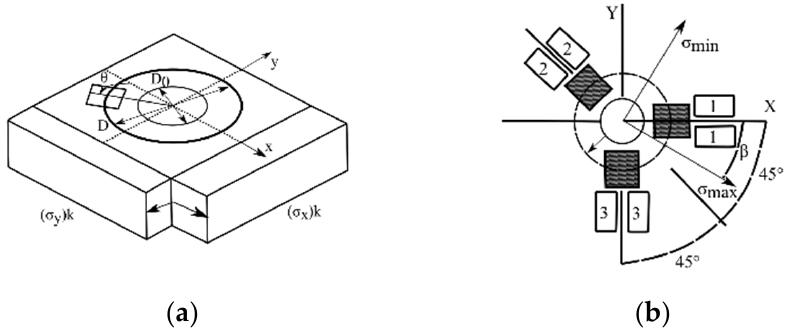
Figure A1. ( a ) Hole geometry and the non-uniform stresses. ( b ) Representation of the hole-drilling method with principal stresses σ max , σ min and the angle β shown with respect to the strain gauges.